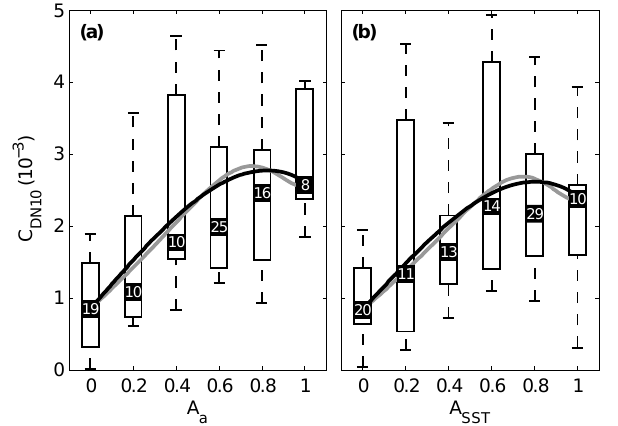
Figure 3. As in Fig. 2, but for Barents Sea flights only (see Table 2 for details of flights).